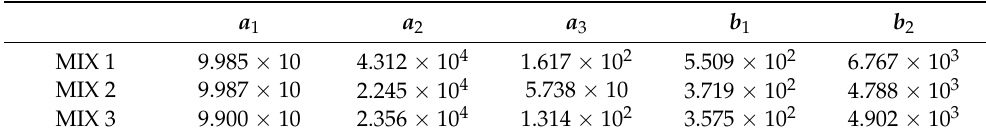
Table 3. Summary of constant coefficients for the estimated saturation curves determined by non- linear regression analysis.